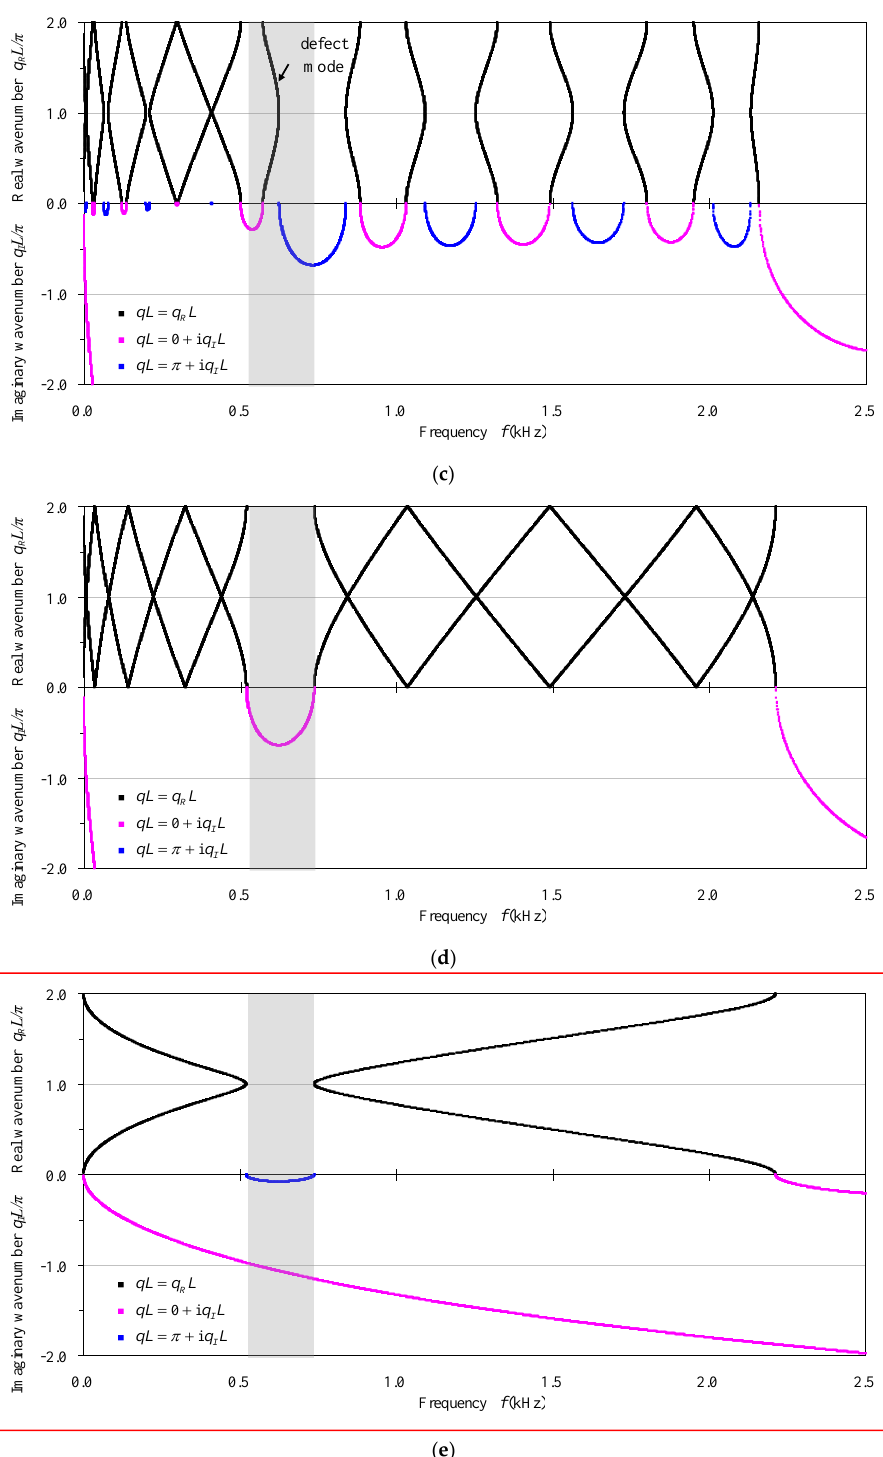
Figure 7. The transmissions and the band structures within low frequency range f ≤ 2.5 kHz: ( a ) Theoretical and experimental transmissions of the defected phononic crystal beam and the computed transmission of the counterpart perfect phononic crystal beam by the MRRM; ( b ) Band structures of the defected phononic crystal beam as a supercell by the TMM; ( c ) Band structures of the defected phononic crystal beam as a supercell by the MRRM; ( d ) Band structures of the perfect phononic crystal beam based on supercell of eight unit cells by the MRRM; ( e ) Band structures of the perfect phononic crystal beam based on one unit cell by the